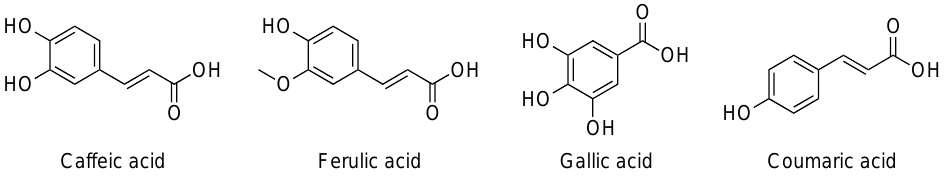
Figure 5. Chemical structures of representative polyphenolic acids detected in the investigated extracts.